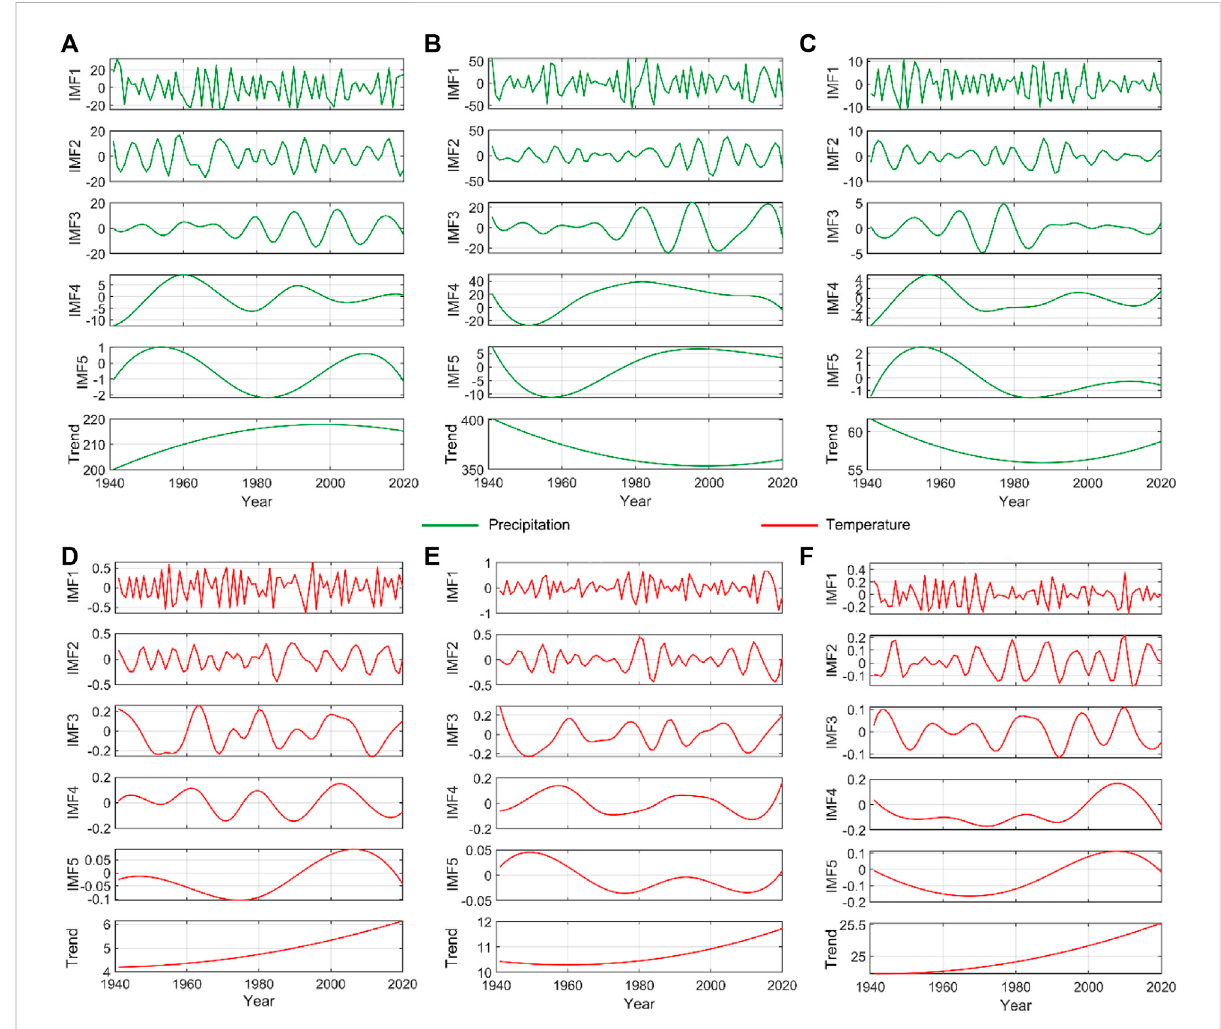
FIGURE 8 Time series of the precipitation and temperature in the PCA (A,D) , NAm (B,E) and NAf (C,F) based on the